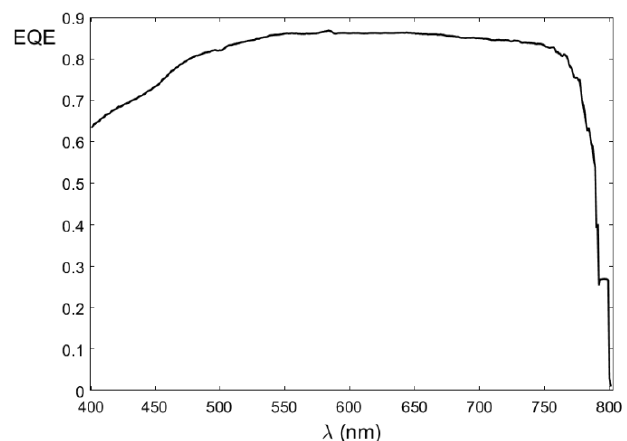
Figure 3. EQE vs. wavelength for the planar structure.